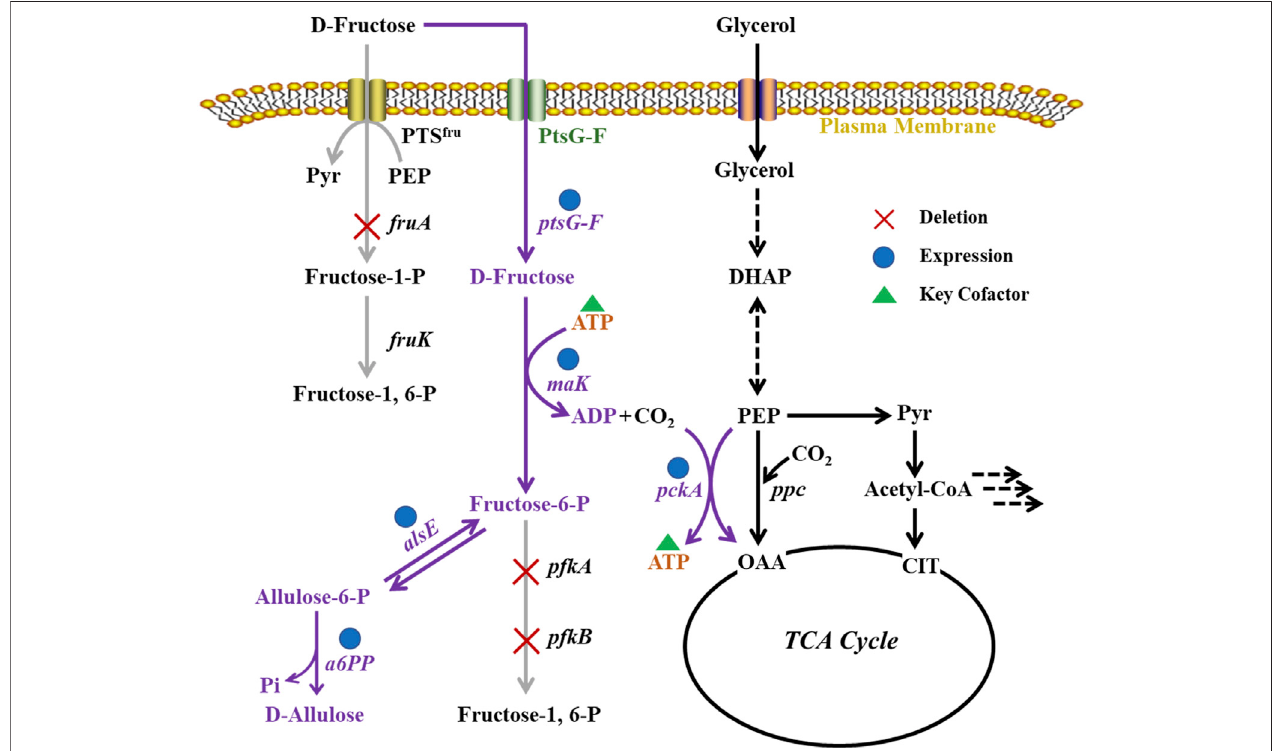
FIGURE 1 | Metabolic pathways in E. coli cell factory for production of D-allulose from D-fructose via phosphorylation-dephosphorylation.